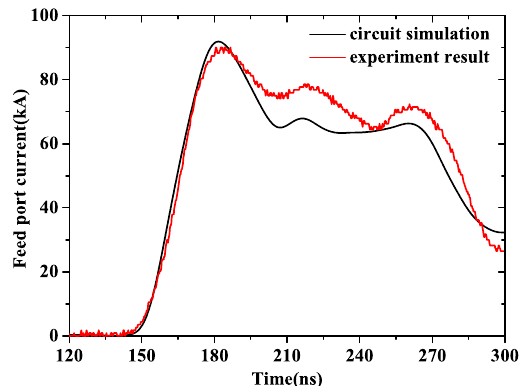
FIG. 12. Comparison of the simulation (black solid line) and measurement result (red solid line) of the current waveforms at the induction cavity feed port